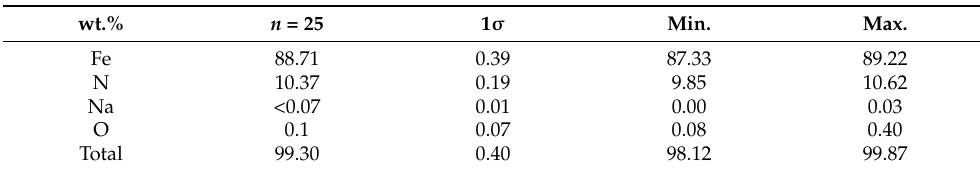
Table 3. Average elemental composition of siderazot grains from electron microprobe analysis averaged over 25 spots. wt.%